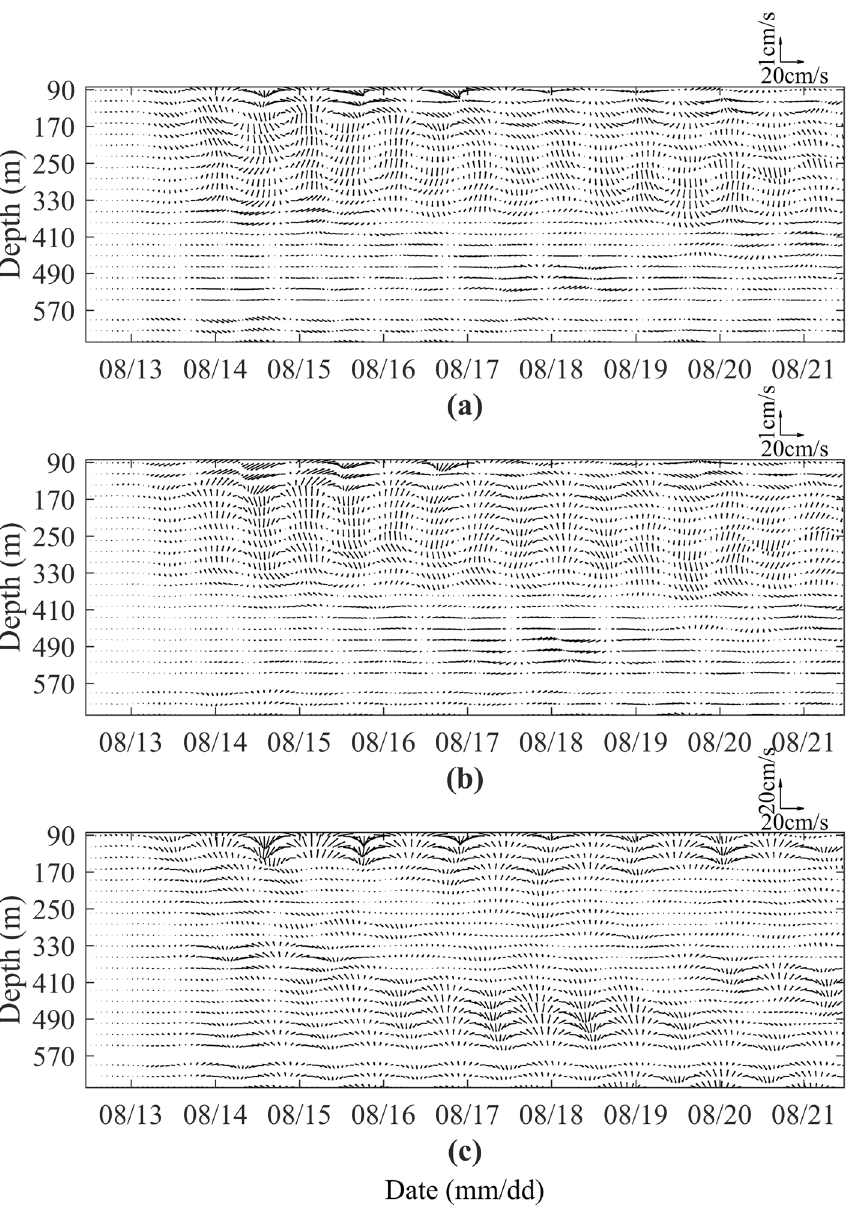
Figure 10. Spatio-temporal distribution of the near-inertial zonal-vertical current velocity ( a ), meridional- vertical current velocity ( b ) and zonal-meridional current velocity ( c ) during the passage of typhoons